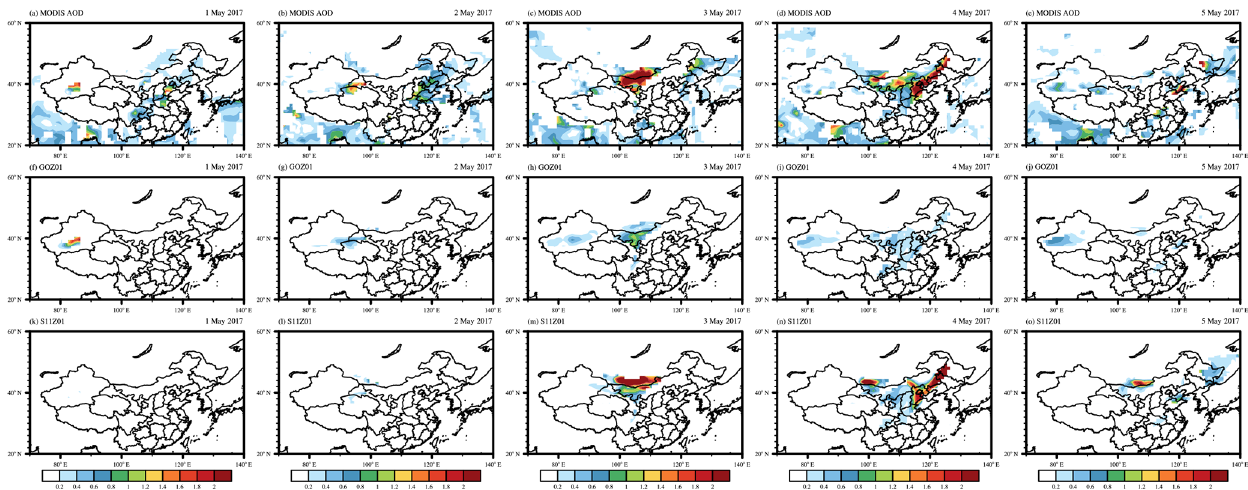
Figure 9. Simulated and observed mean AOD over the simulation period 1–5 May. Panels (a) – (e) show the distribution of daily mean aerosol optical depth (AOD) at 550nm derived from MODIS-Aqua. Panels (f) – (j) show the WRF-Chem-simulated AOD for the GOBS95 experiment. Panels (k) – (n) show the WRF-Chem-simulated AOD for the S11Z01 experiment. The model results are extracted from the simulation results at 13:00 local time for each region to match the MODIS observation time (for details see Sect. 2.5). All of the other experiments and for the period 1–6 May are shown in Fig. S1. Grid points without valid MODIS AOD retrieval are masked for both observational and model results.